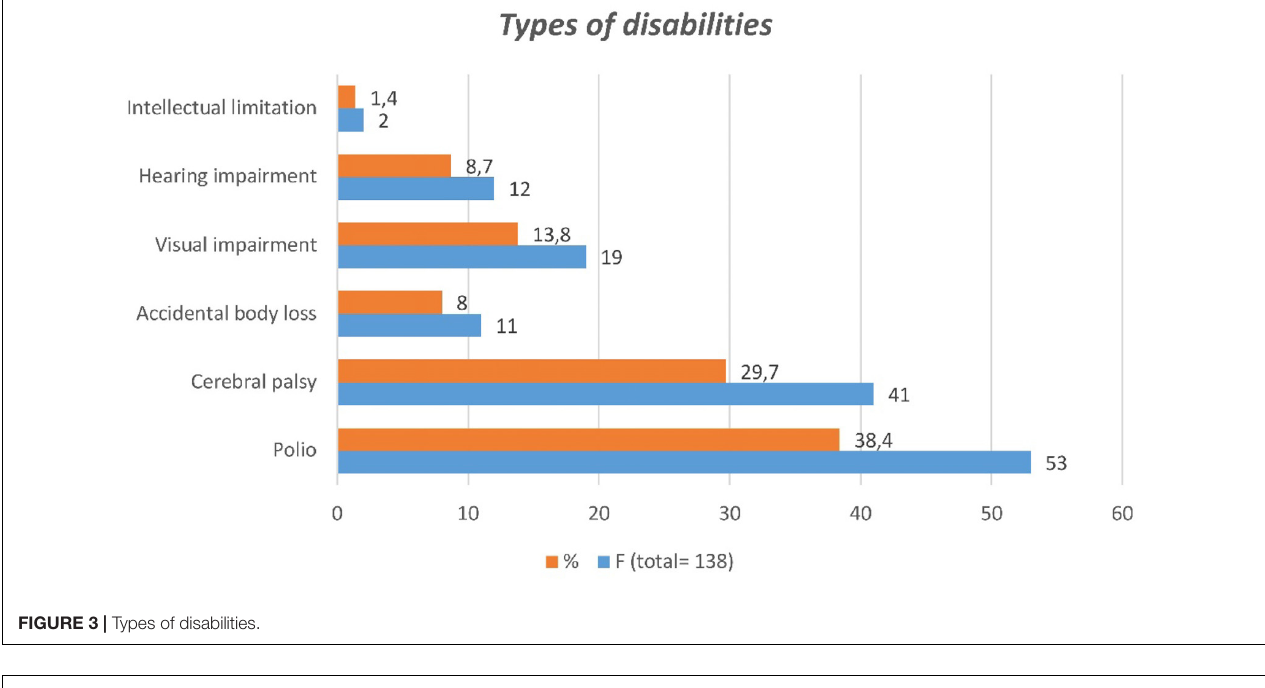
FIGURE 3 | Types of disabilities.